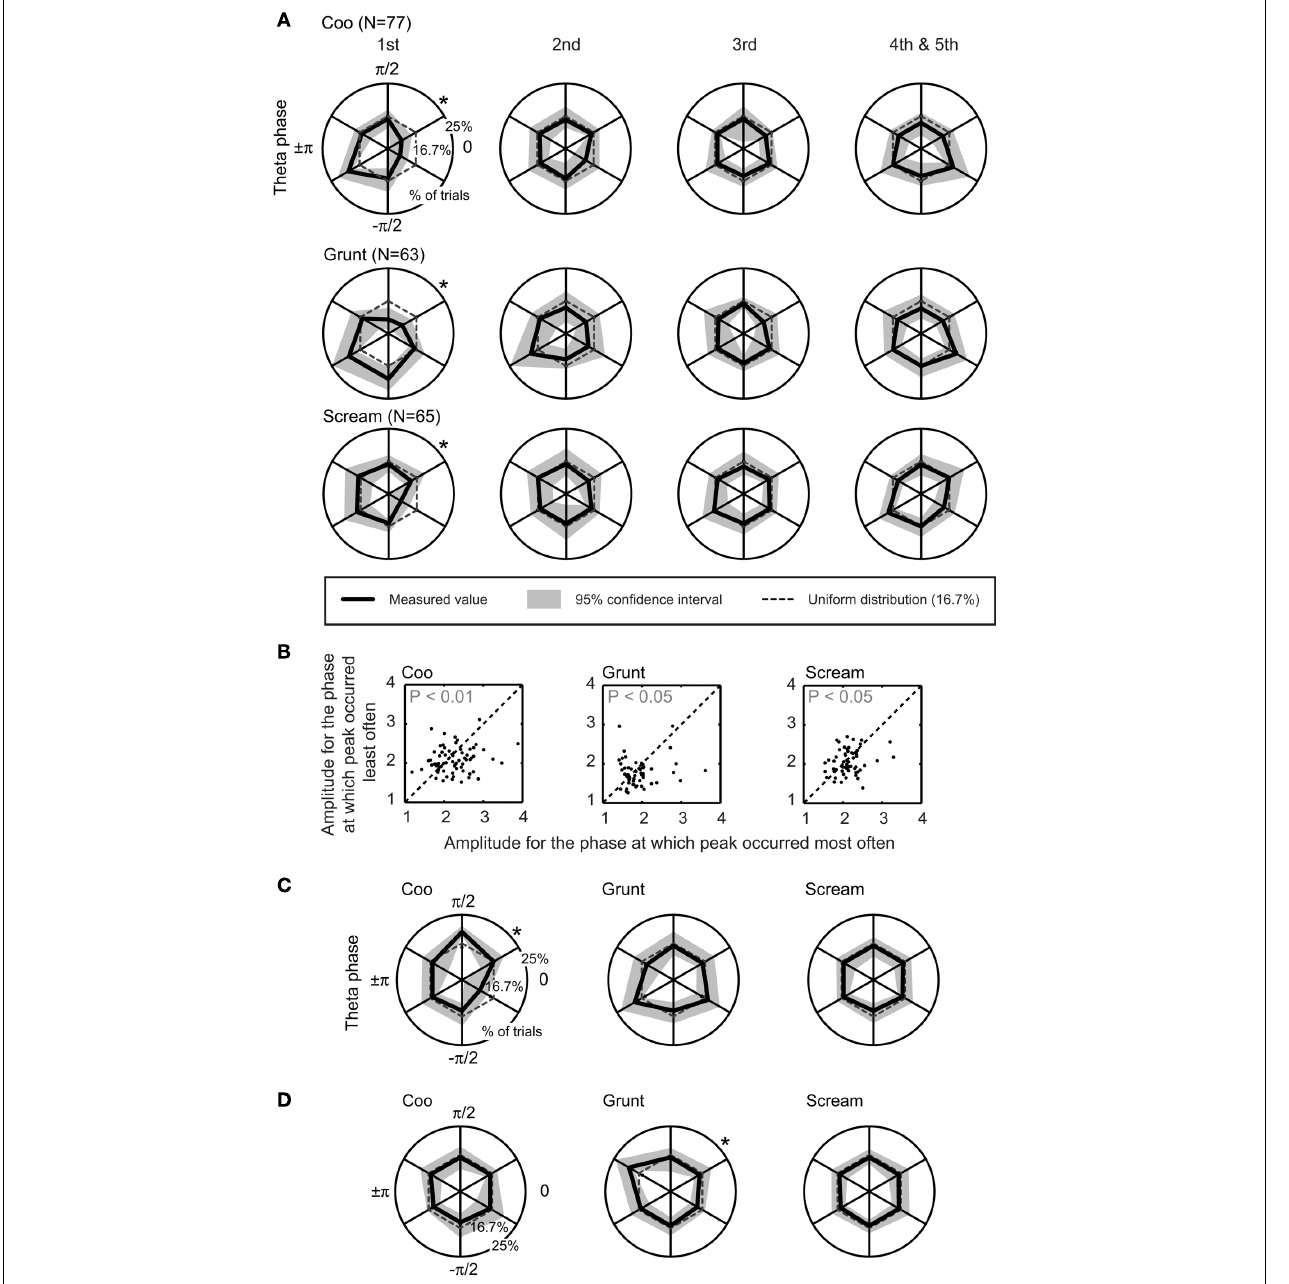
basis and as a function of vocalization, the relationship between the mean peak amplitude of the gamma band at the most and least common theta phase; these values were extracted only from data elicited by the first vocalization presentation.The dotted line is the line of equal peak amplitude (i.e., a line with a slope of 1). On average, the peak amplitude of the gamma band at the most common phase was reliably ( p < 0.05) larger than that at the least common phase.The plots in (C) show the distribution of the alpha phase at the gamma-band peak time during the first presentation of each vocalization.The plots in (D) show the distribution of the beta phase at the gamma-band peak time during the first presentation of each vocalization. For the plots in (C,D) , the solid black line, the gray area surrounding the black line, dotted lines, and the asterisks are in the same format as those described in (A)